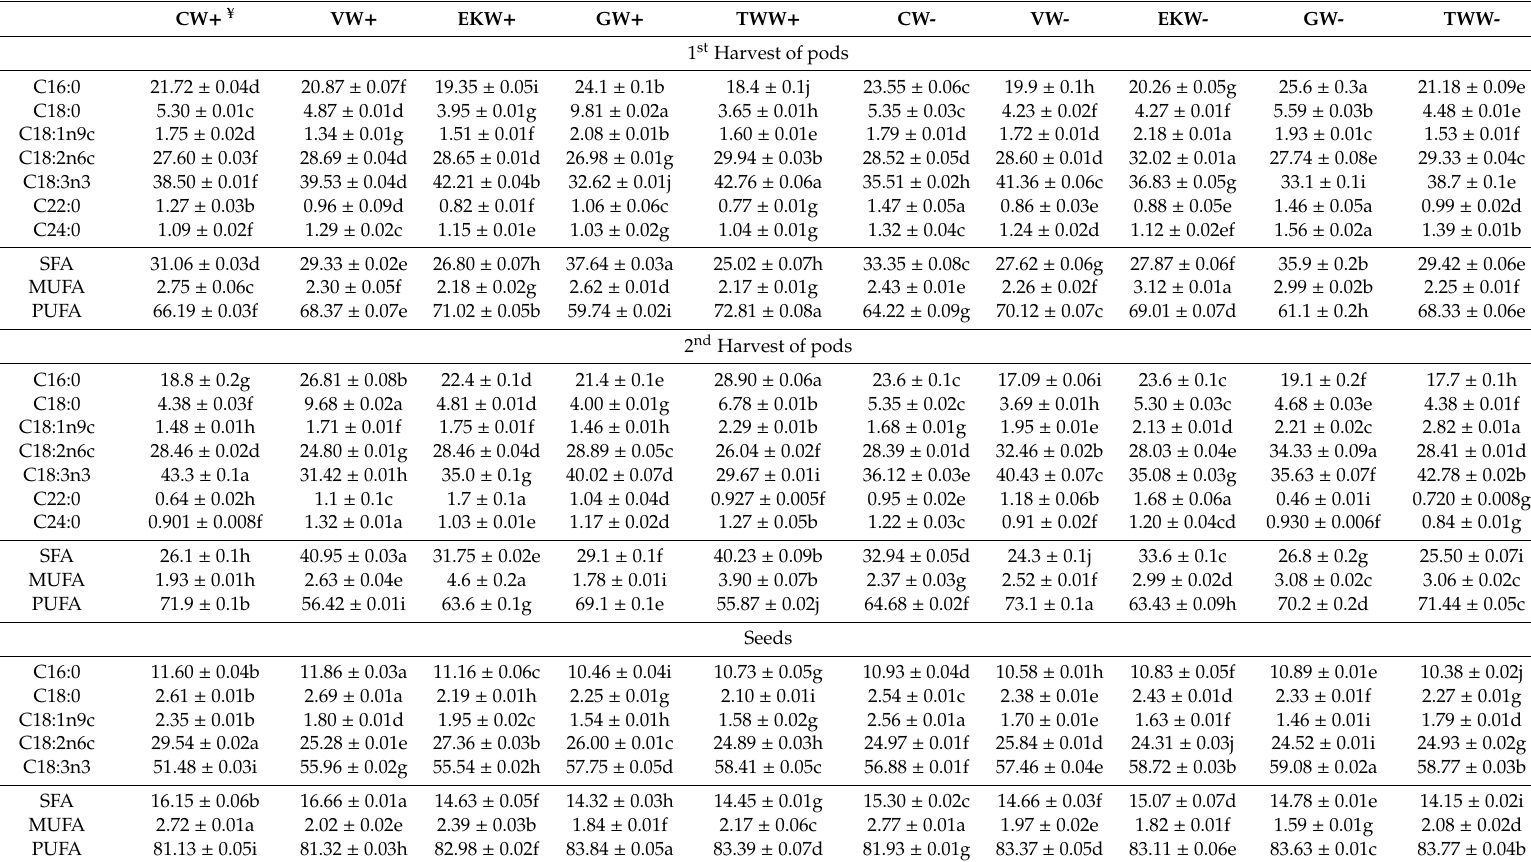
Table 7. The main fatty acids composition (%) of the studied pods and seeds of common bean (mean ±